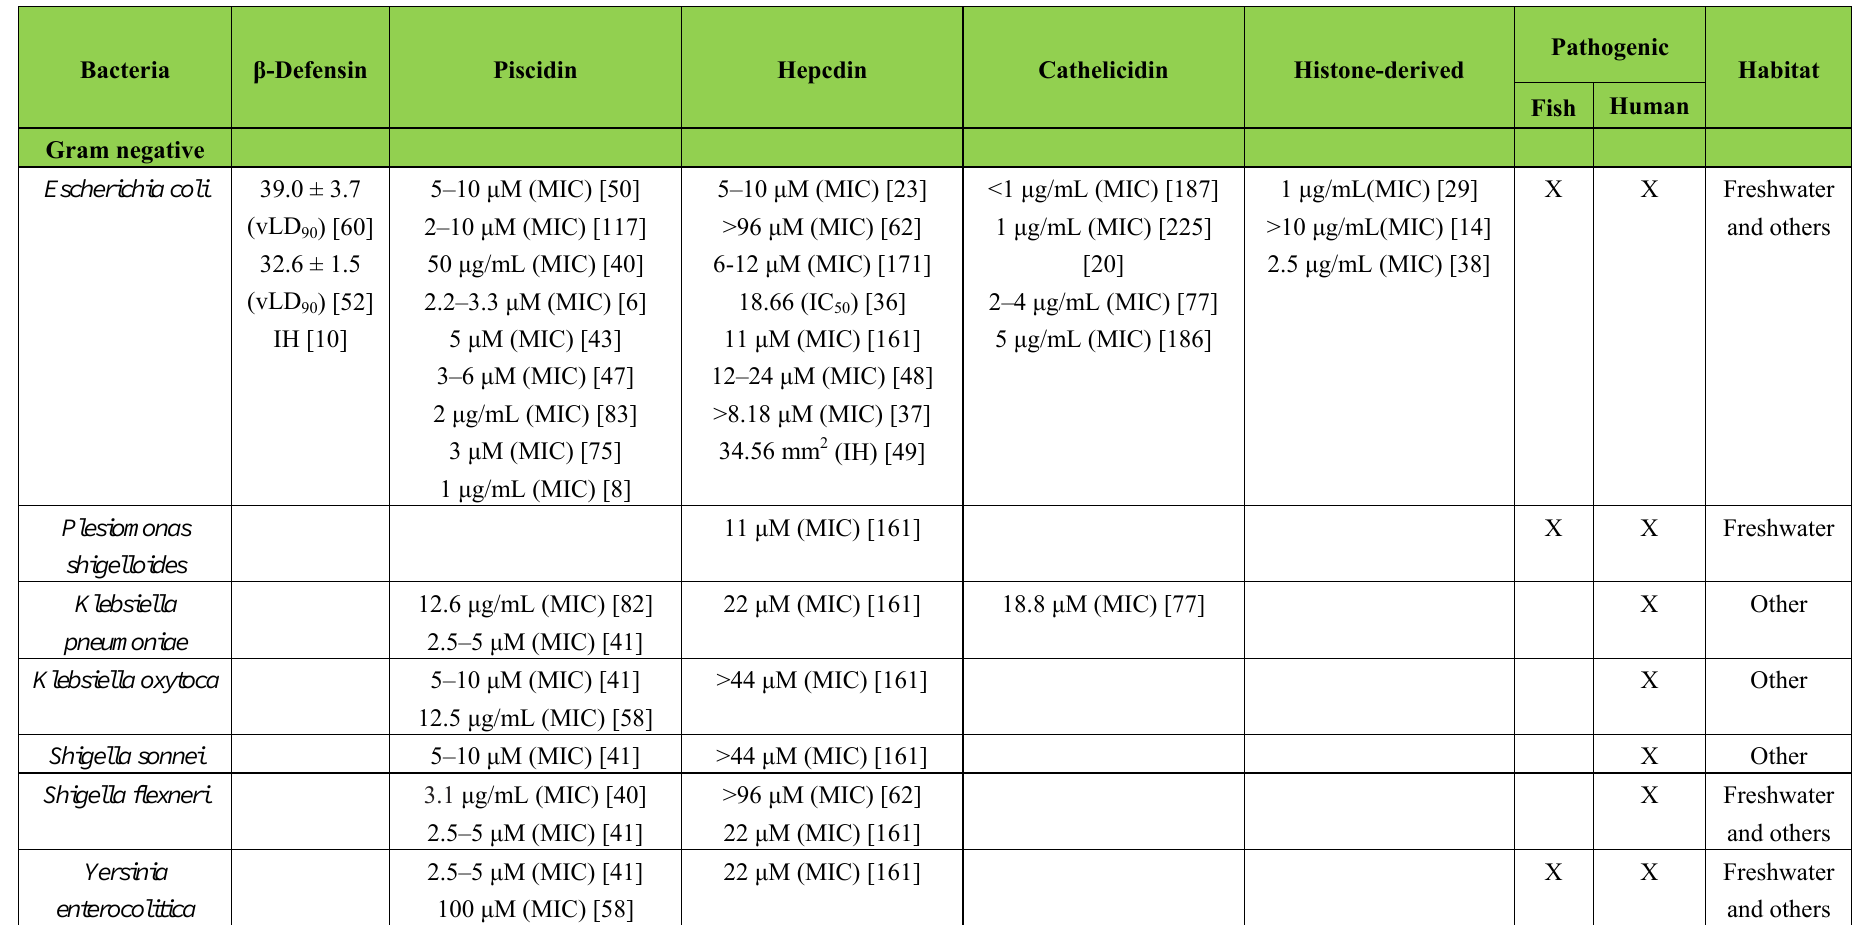
Table S1. Antimicrobial activity of fish AMPs. Bacteria and fungi included MICs ( μ M, or μ g/mL will be indicated) values, MLCs ( μ M), vLD (virtual 90% lethal dose, mg/mL [mean ± SEM]) or IC ( μ M). If values are not included antimicrobial activity was assessed by 90 50 inhibitory halo (IH) and size in millimeter was not presented, if so, is indicated. If isoforms were tested, the best performance value was used. For parasites, the minimum protozoacidal concentration (PC ) or MIC is indicated. Habitat of microorganisms are indicated (freshwater, marine min or